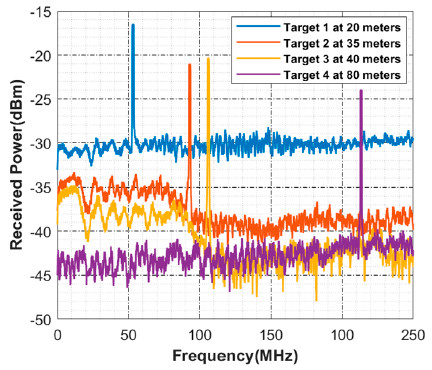
Figure 2. Detection of four targets under clear weather